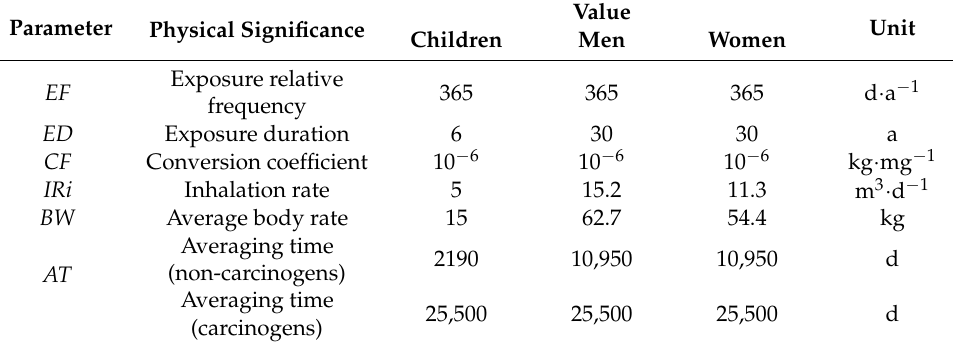
Table 2. The exposure parameter